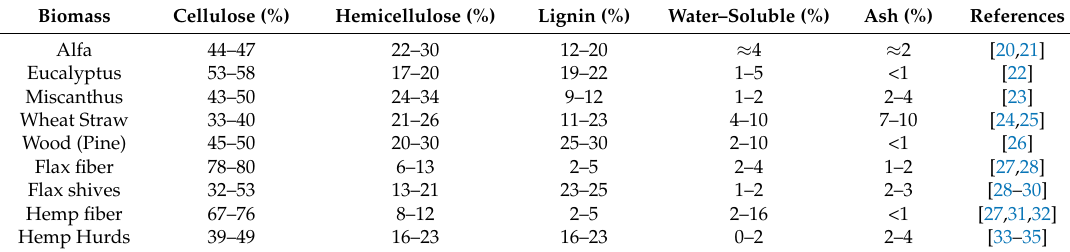
Table 1. Composition of different lignocellulosic biomasses, on a dry